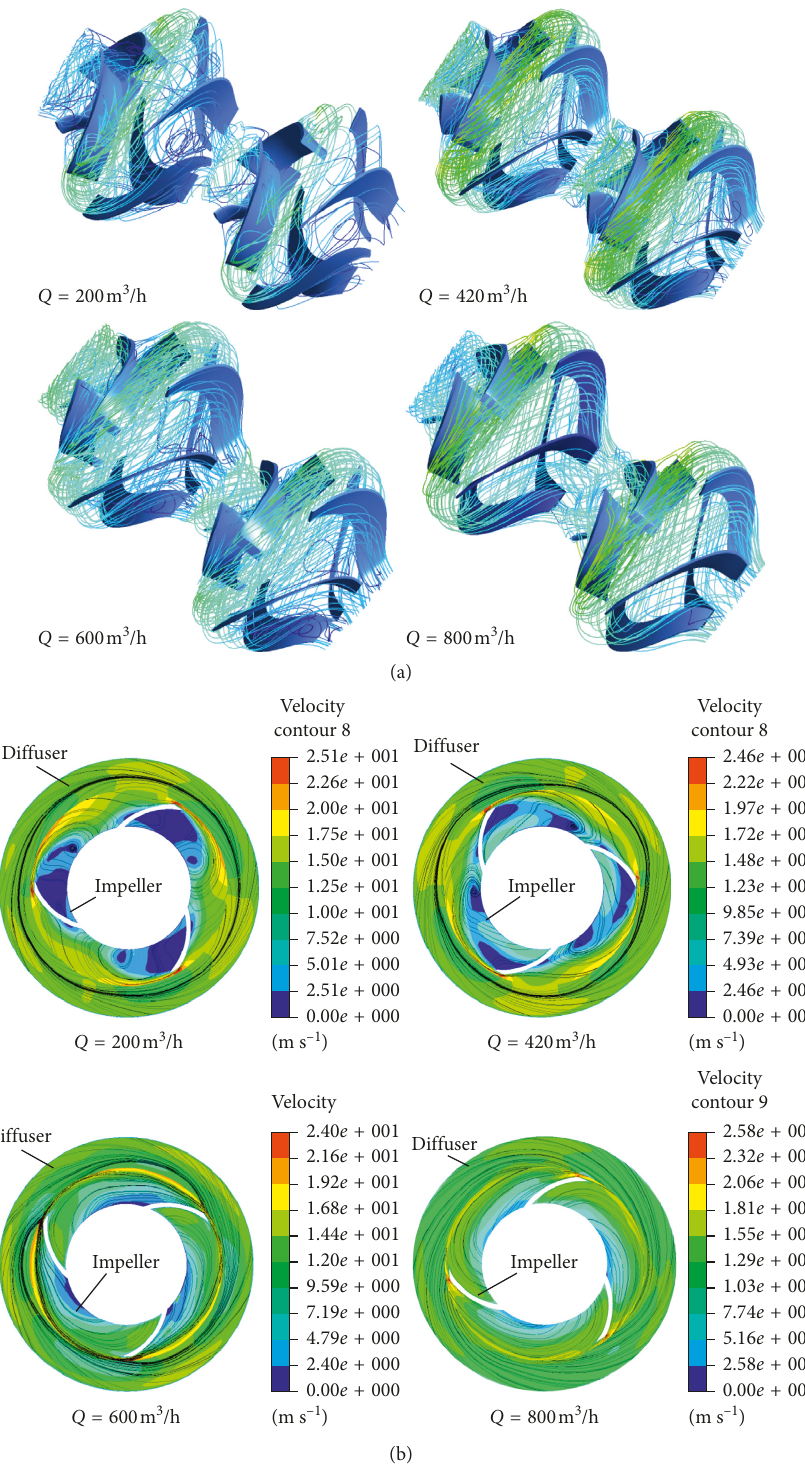
Figure 13: Streamline distribution for different flow rates (a) in the two-stage pump and (b) z �